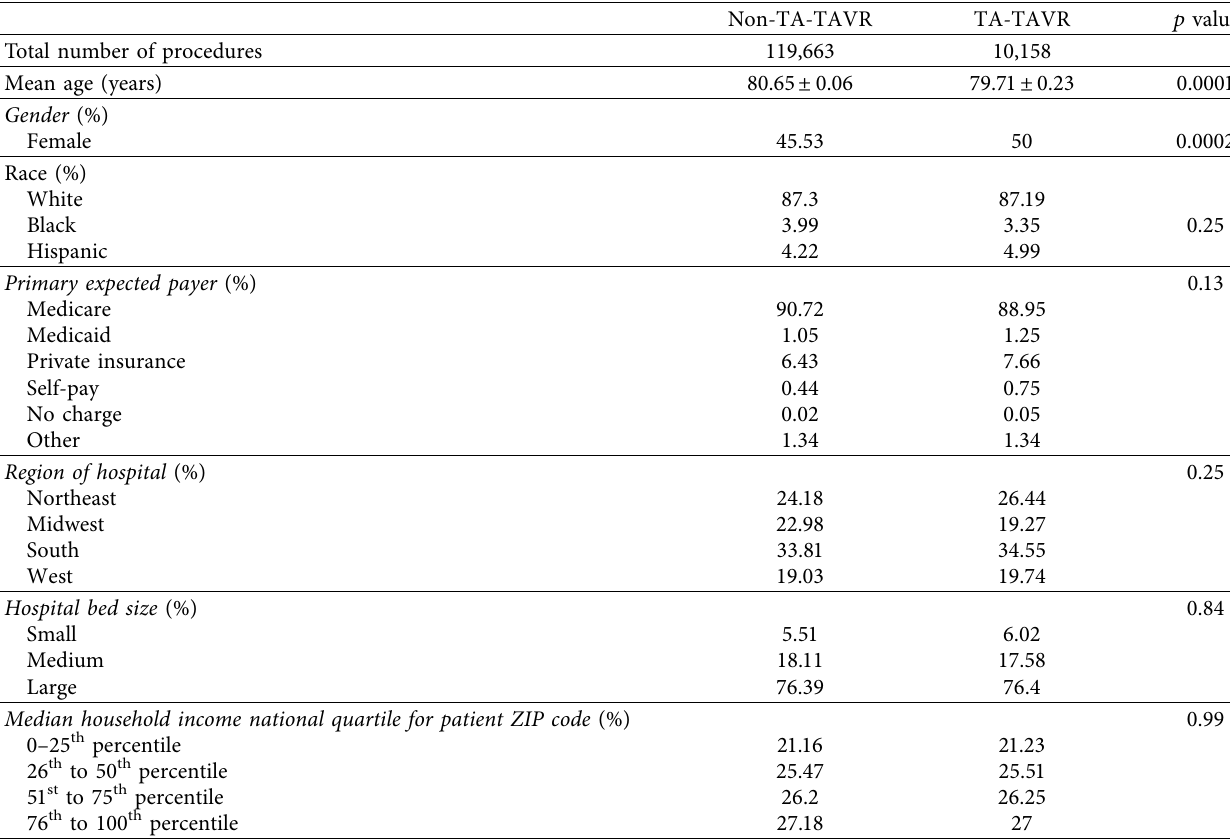
Table 1: Demographics and hospital characteristics in patients undergoing TAVR through transapical vs. nontransapical approaches.